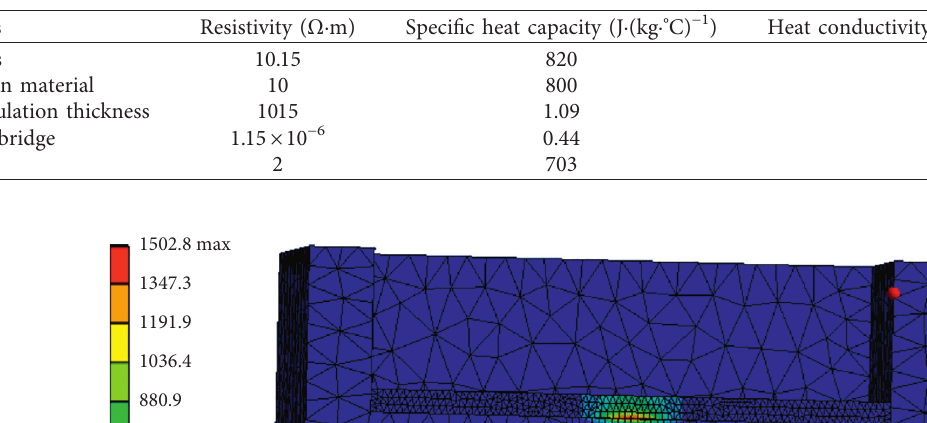
Table 3: Material electrothermal physical parameters.